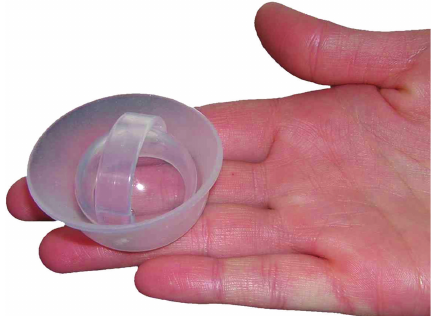
Figure 2: Femcap (courtesy of Alfred